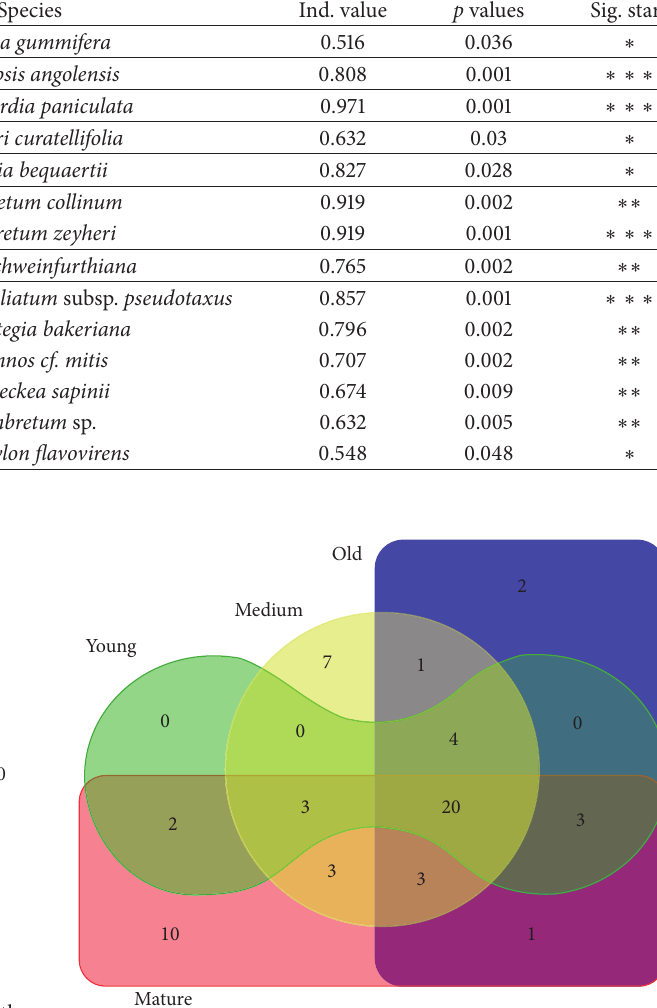
Figure 5: Principal Coordinates Analysis (PCoA) showing the relationship between the tree species composition and fallows stages in the Cusseque study area (young fallows: green; medium-aged fallows: yellow; old fallows: blue; and mature forests: red).